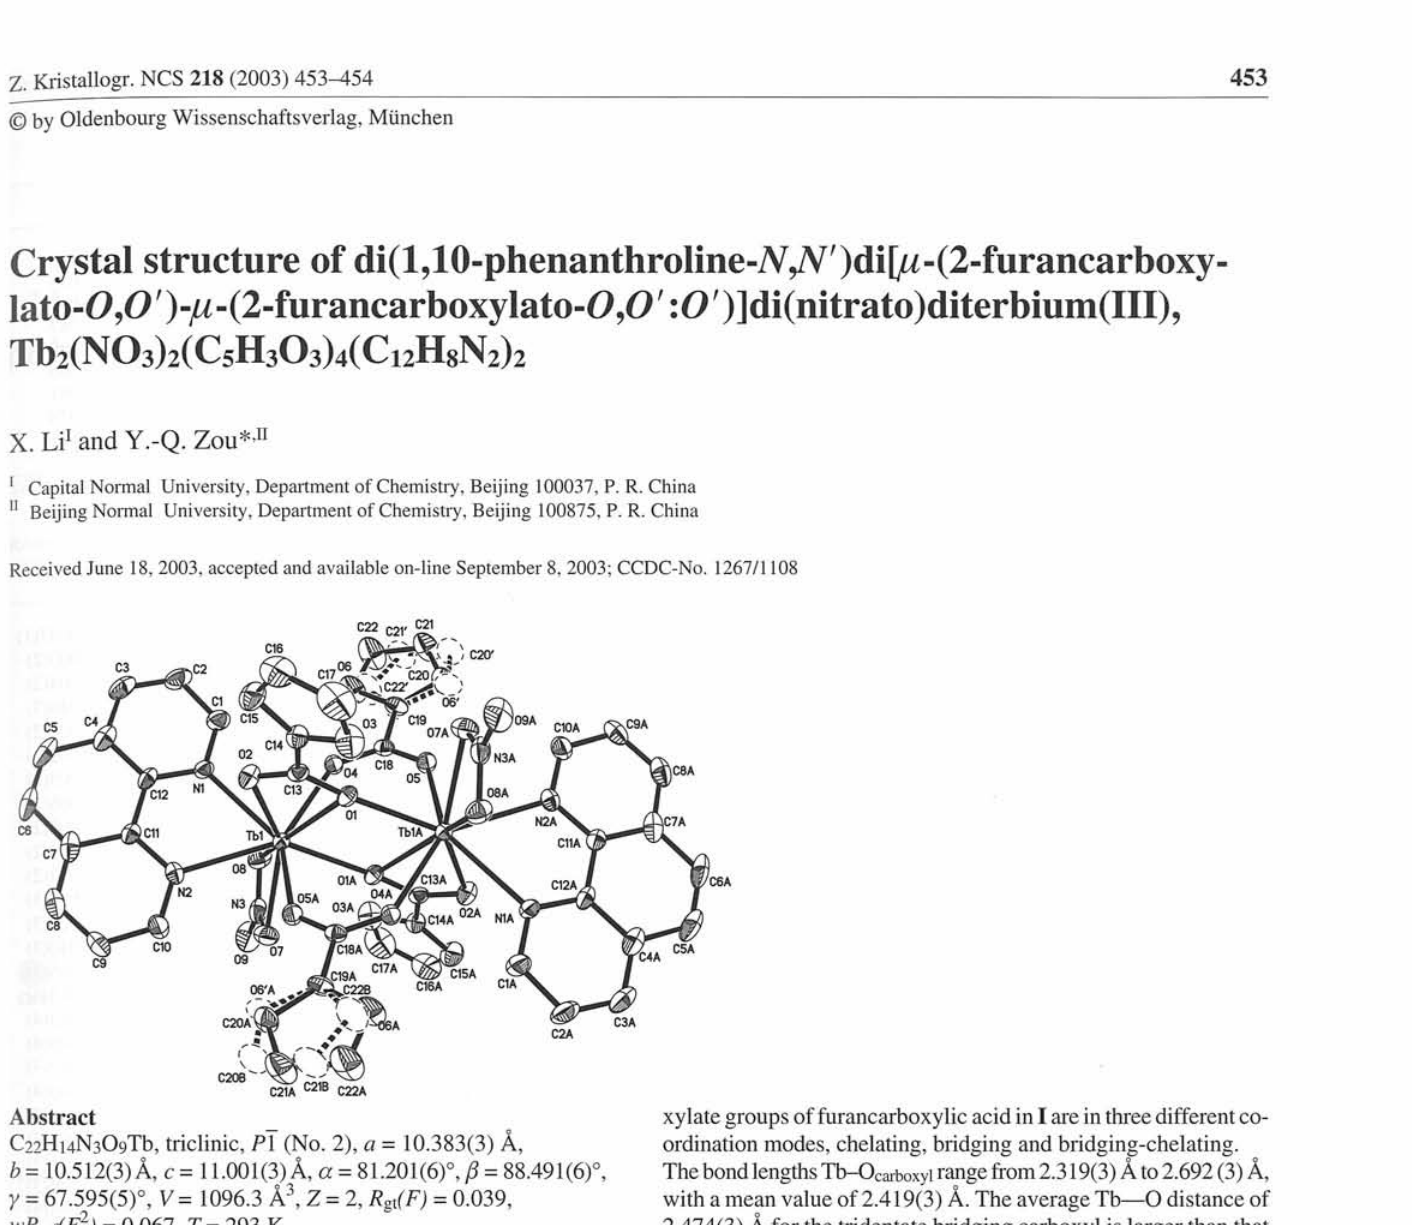
Table 1. Data collection and